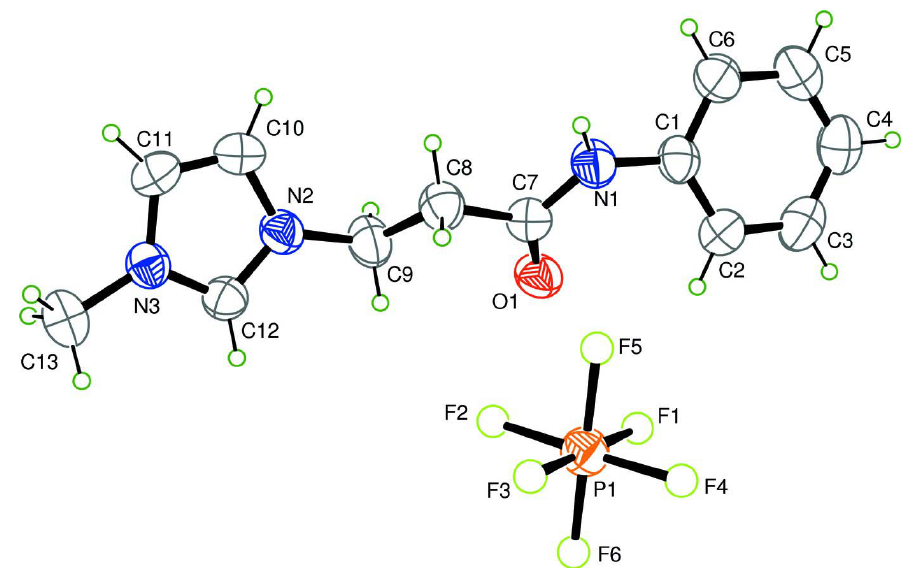
Figure 1 View of the title molecule with the atom-labelling scheme. Displacement ellipsoids are drawn at the 50% probability level. H atoms are presented as a small spheres of arbitrary radius.